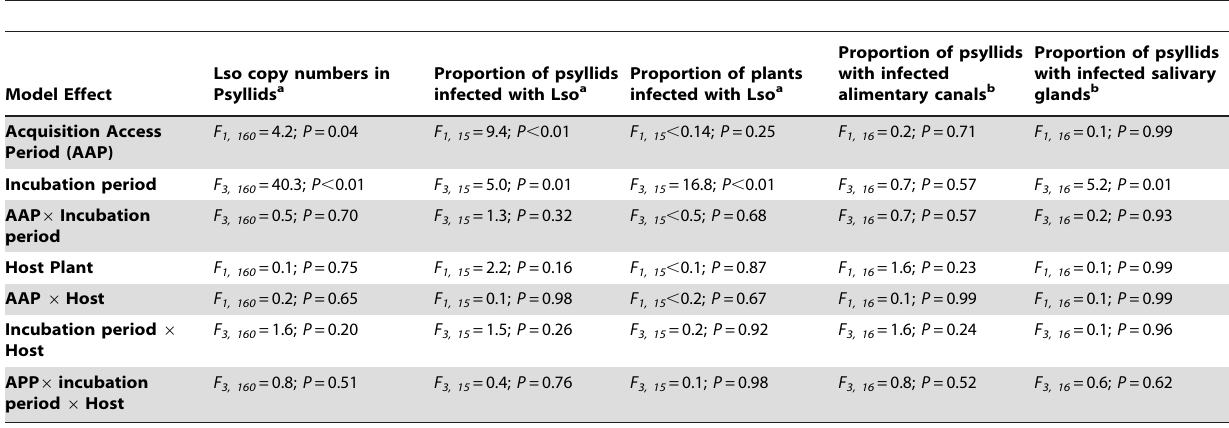
Table 2. Statistical analyses examining Lso copy numbers in psyllids, the proportion of psyllids and plants infected with Lso, and the proportion of psyllids with infected alimentary canals and salivary